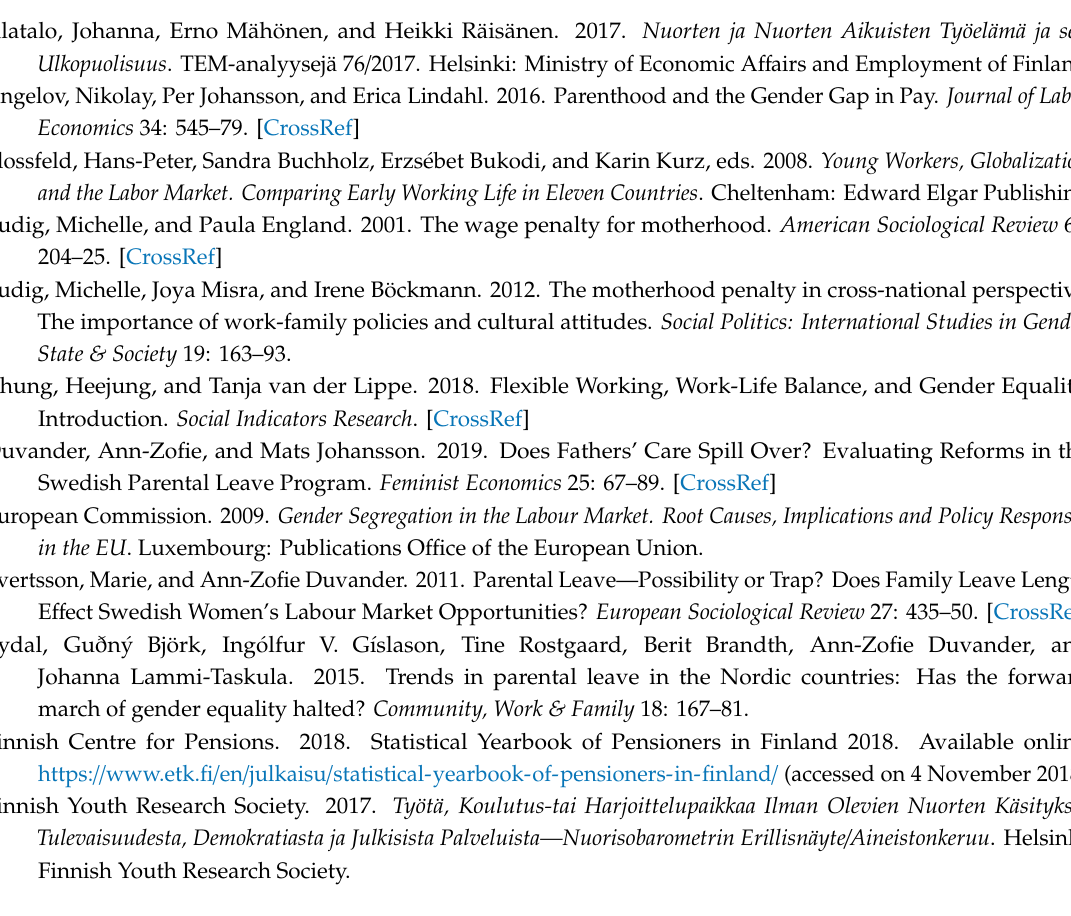
number of groups.